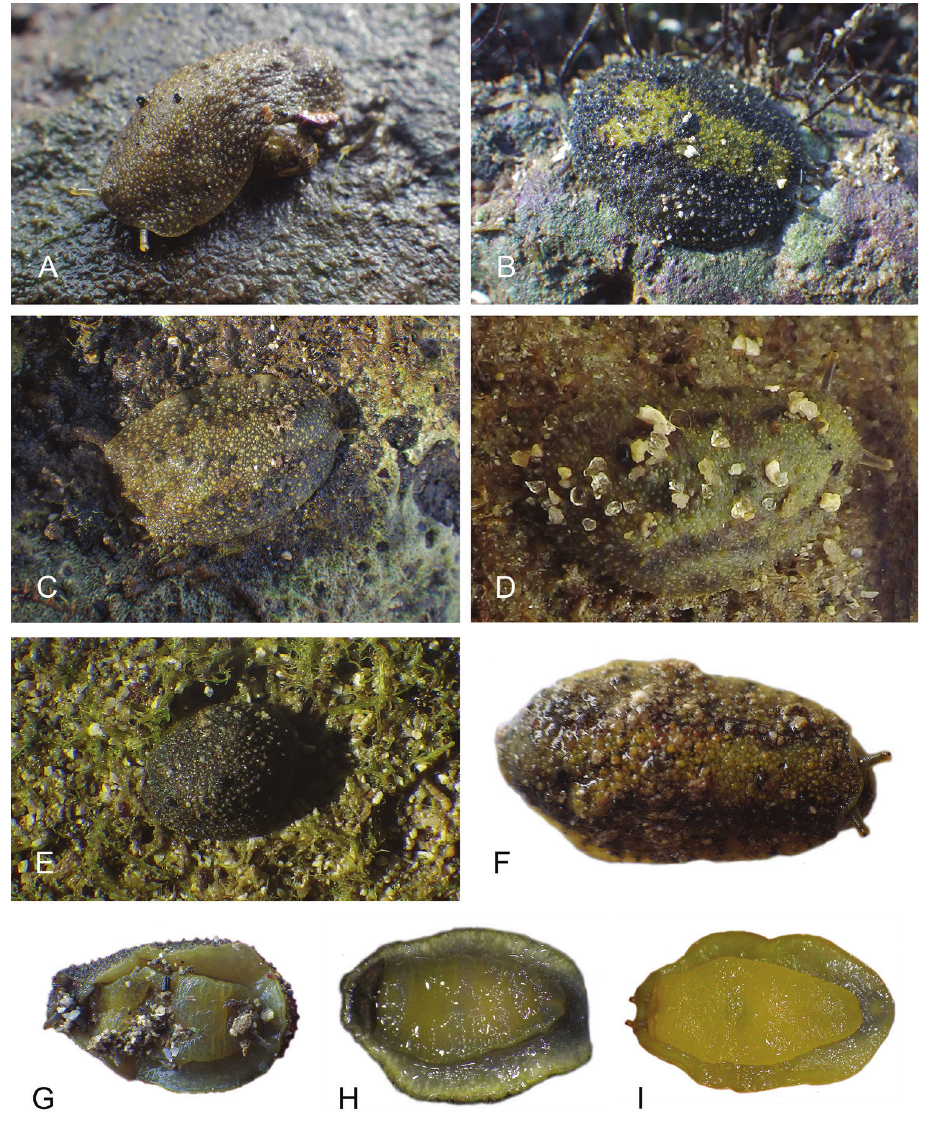
Figure 55. Live specimens, Wallaconchis comendadori . A Dorsal view, 16 mm long [3133], Indonesia, Bali (UMIZ 00064) B Dorsal view, 18 mm long [2985], Indonesia, Lombok (UMIZ 00063) C Dorsal view, 13 mm long [3131], Indonesia, Bali (UMIZ 00064) D Dorsal view, 12 mm long [2725], Indonesia, Ambon (UMIZ 00061) E Dorsal view, 7 mm long [2983], Indonesia, Lombok (UMIZ 00063) F Dor- sal view, holotype, 12 mm long [3626], Philippines, Bohol (PNM 041232) G Ventral view, same as B H Ventral view, 15 mm long [2315], Indonesia, Sulawesi (UMIZ 00060) I Ventral view, 22 mm long [3385], Philippines, Bohol (PNM